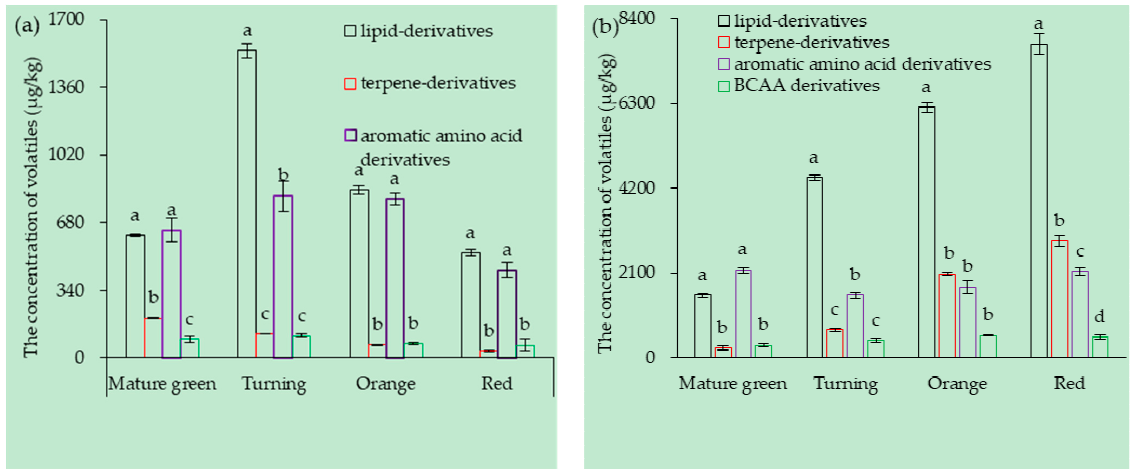
Figure 1. The contents of volatiles derived from different metabolic pathways in tomato fruits (µg/kg): ( a ) TI4001 and ( b ) CI1005. Lower case letters indicate significant differences in volatile contents among different metabolic pathways ( p < 0.05).